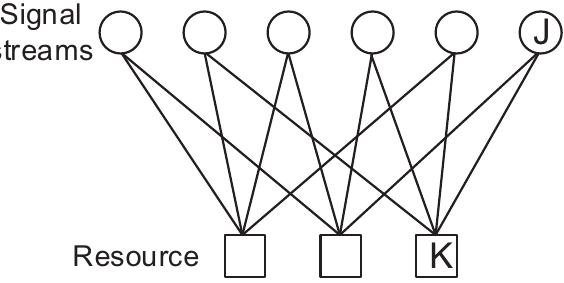
Figure 6. Factor graph of 6 by 3 SCMA systems.